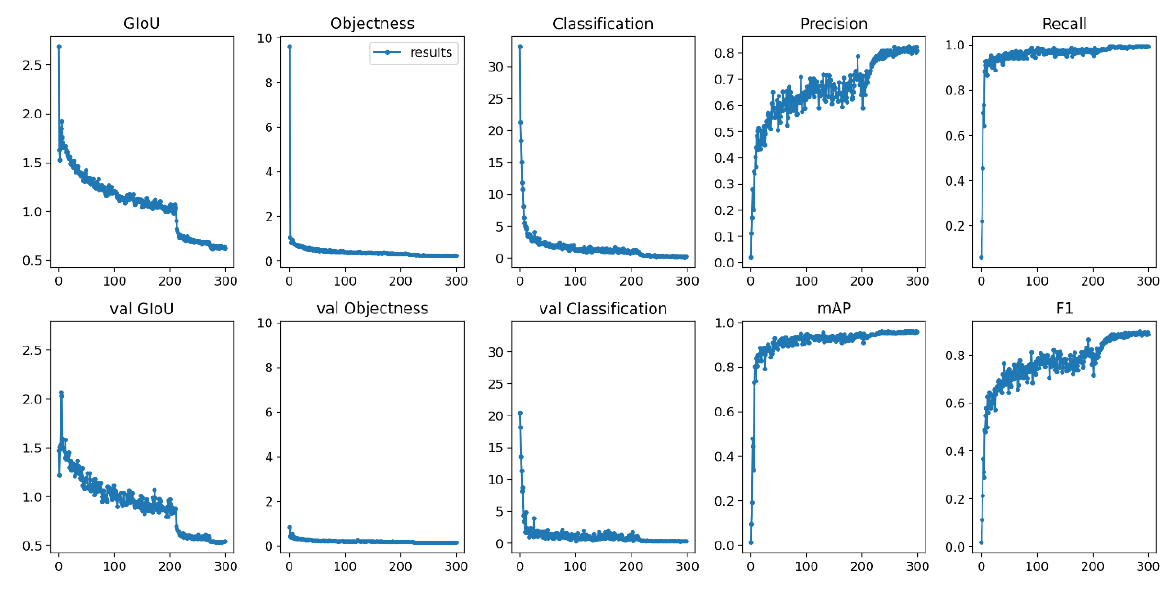
Figure 9. Changes in evaluation criteria during the training process.